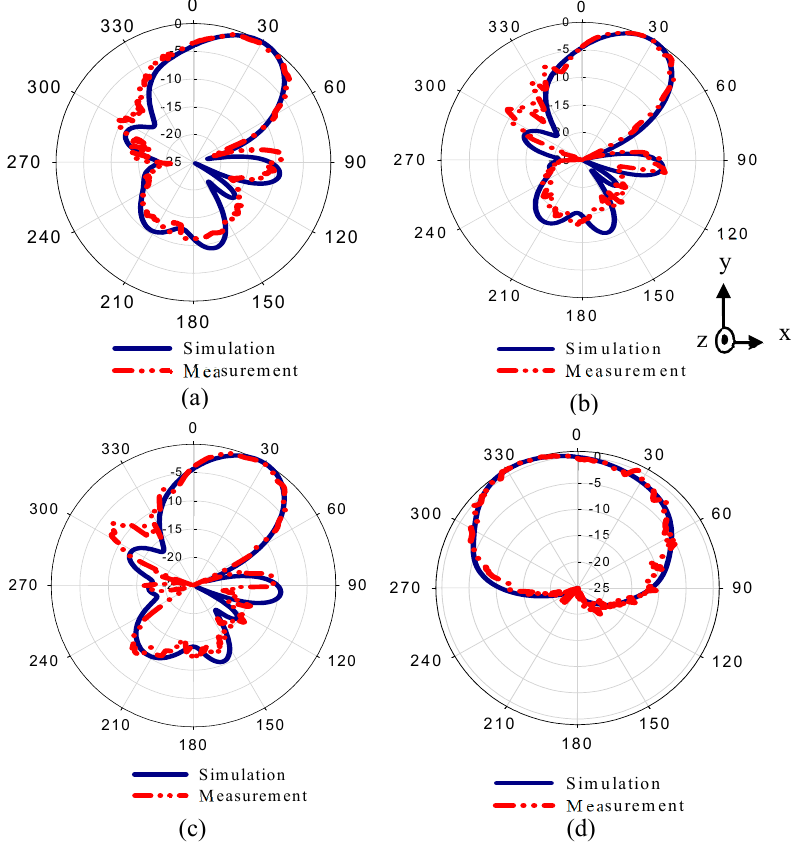
Figure 12. Normalized simulated and measured radiation patterns of the MM antenna in E-plane (xy) at ( a ) 27.7 GHz, ( b ) 28 GHz, and ( c ) 28.3 GHz, and ( d ) in H-plane at 28 GHz.